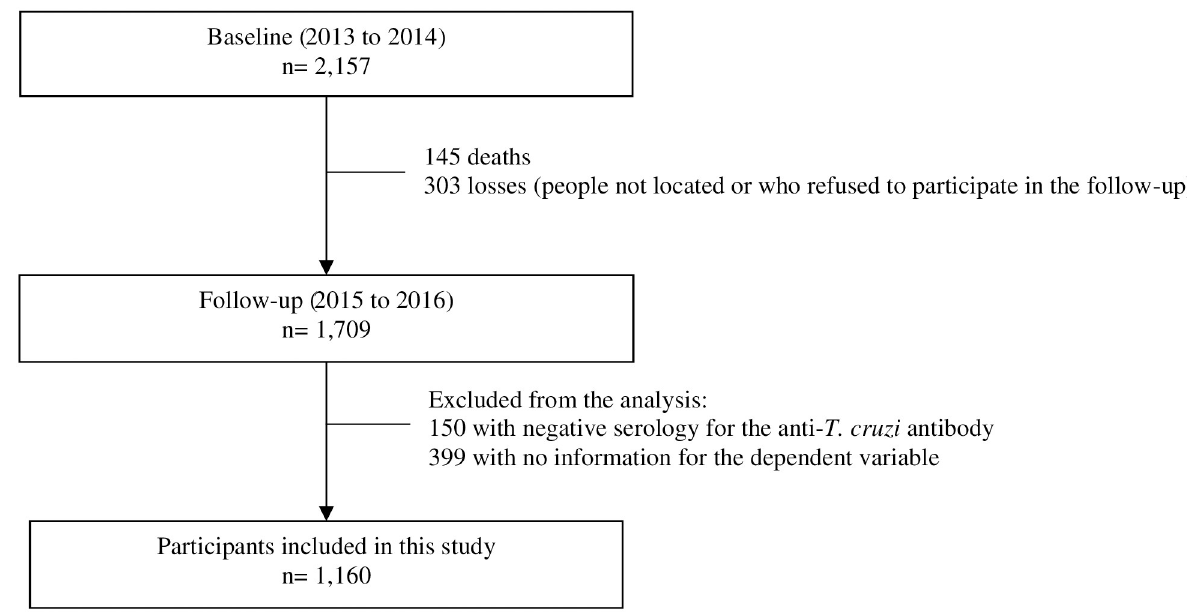
Fig 1. Flowchart of included, lost and excluded CD patients of the study. SaMi-Trop Project, Minas Gerais, Brazil.